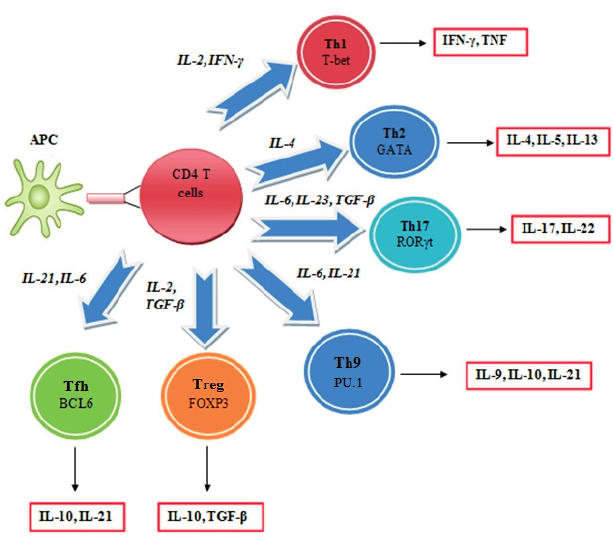
Figure 2. Following recognition of a specific antigen presented by an appropriately activated antigen-presenting cell (APC), CD4 + T cells can differentiate into different subsets determined by the cytokine milieu present when the cell encounters an antigen. These subsets are classified according to the dominant transcription factor in concert with cytokines that they